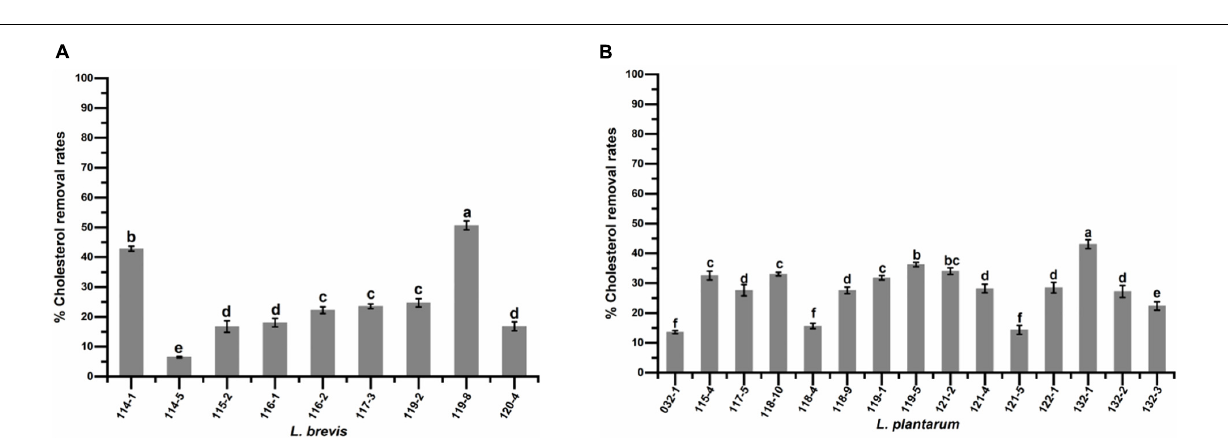
FIGURE 7 | Cholesterol assimilation ability of (A) Lactobacillus brevis strains and (B) Lactobacillus plantarum strains isolated from fermented vegetables in Shaanxi, China. Data shown are mean ± SD of triplicate values of independent experiments. Different letters indicate significantly different means ( P <